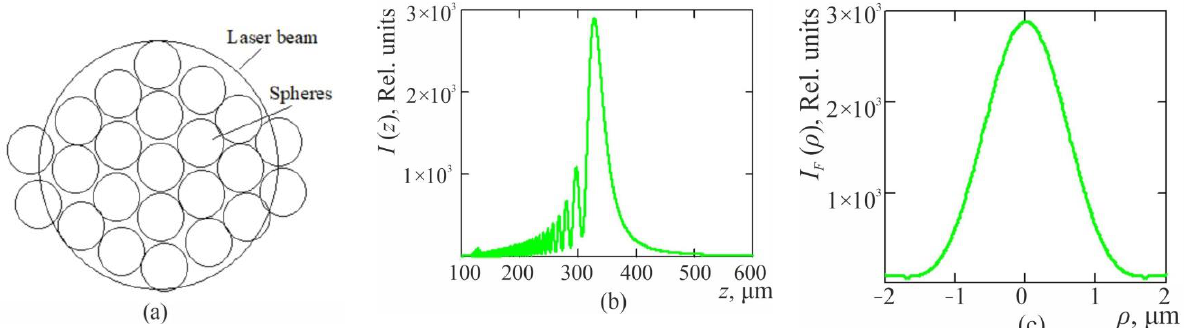
Figure 1. Scheme of laser beam with a 200 µ m spheres coating. ( a ) Scheme of laser irradiation. The diameter of the laser beam is ≈ 1.5 × 10 3 µ m. The diameter of the spheres is ≈ 200 µ m. ( b , c ) Structures of light intensity I ( θ , z ) of a laser beam in pure water focused by a single sphere 200 µ m in diameter: I (0, z )–along the beam ( b ) and I F ( ρ ) in geometrical focus ( c ), where z is the distance along the beam and ρ is the distance along the radius.